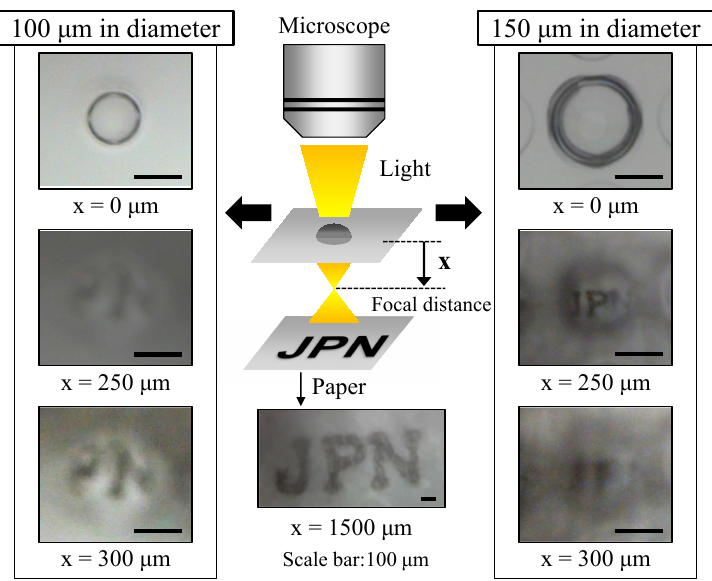
Figure 10. Optical microscope images of different microlenses formed by the same droplets but on different